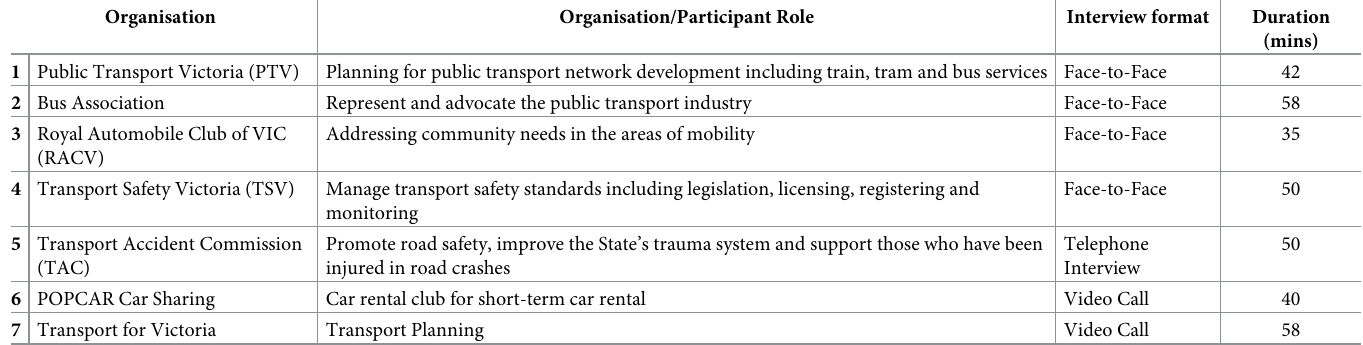
Table 1. Details of the stakeholders who participated in the interviews.